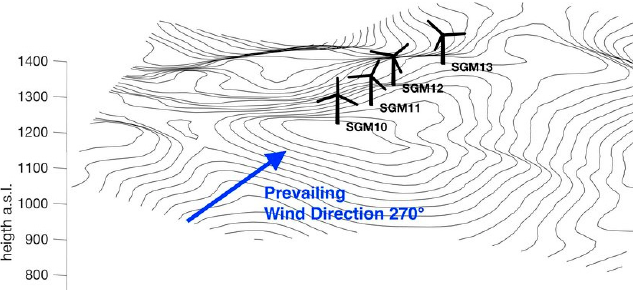
Figure 17. The layout and the inter-turbine distance of the sub-cluster investigated [3].